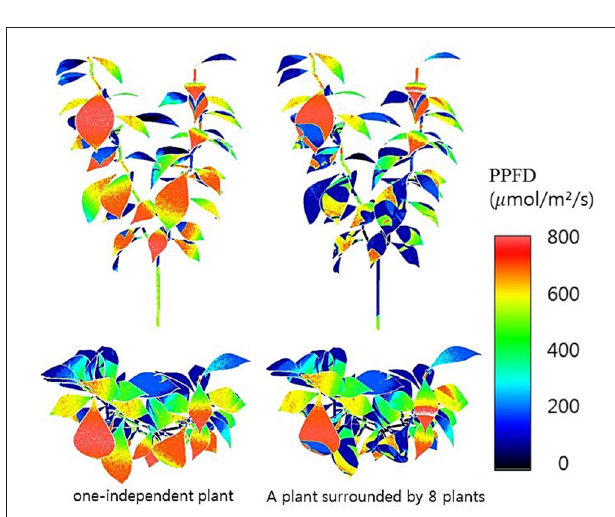
FIGURE 7 | 3D simulated results of intercepted irradiances of a single plant at 12:00 not surrounded (left) and surrounded (right) by eight plants.